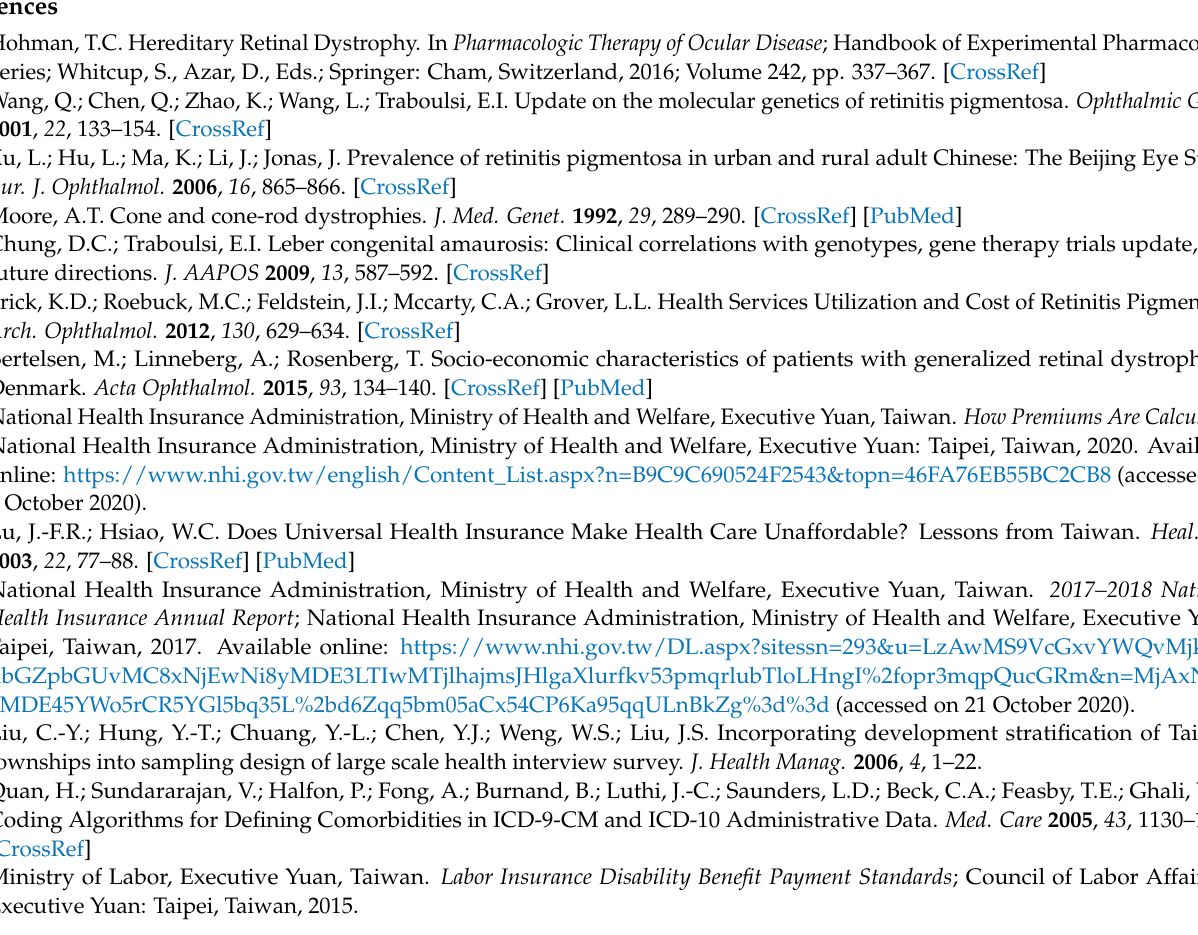
Table S3: Disability percentage conversion